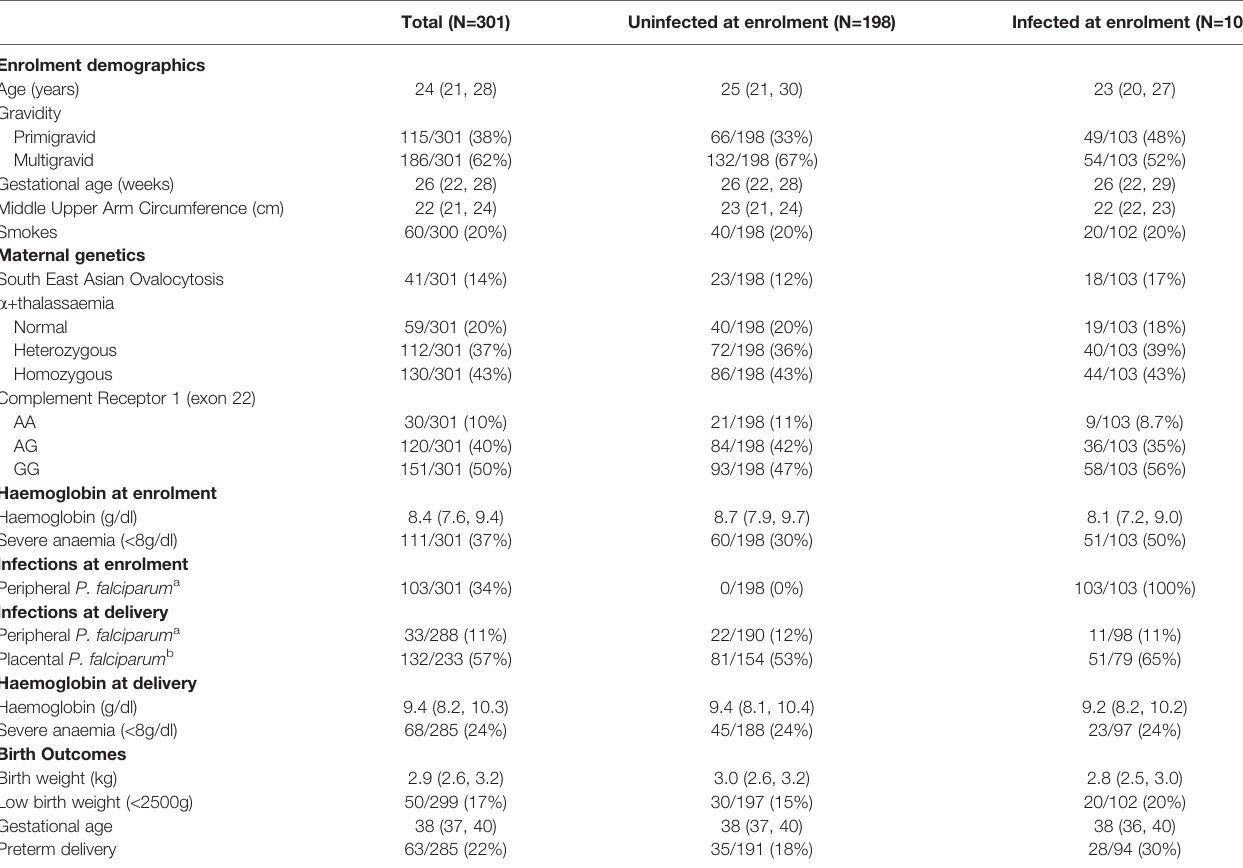
TABLE 1 | Study population characteristics in women with and without microscopic peripheral P. falciparum infection at enrolment. Total